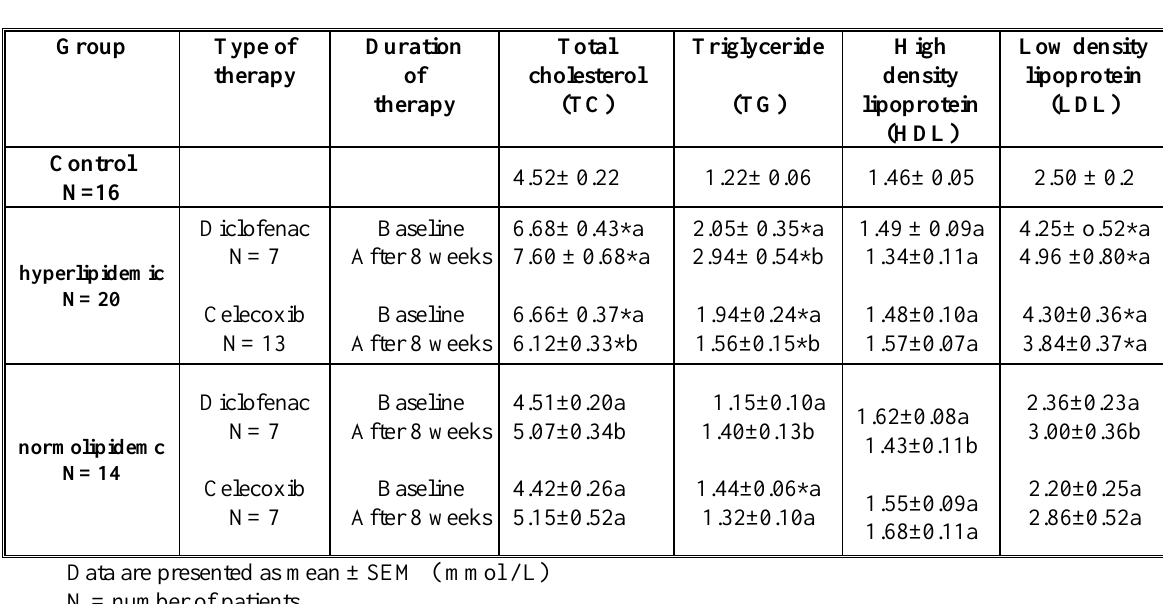
Table(1): Effect of treatment with diclofenac or celecoxib on lipid profile in normolipidemic and hyperlipidemic type 2 diabetic